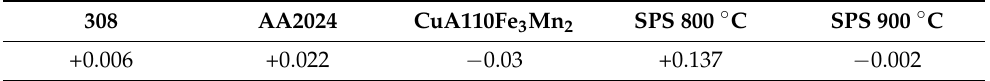
Table 5. Influence of being in a corrosive environment on the mass of metal